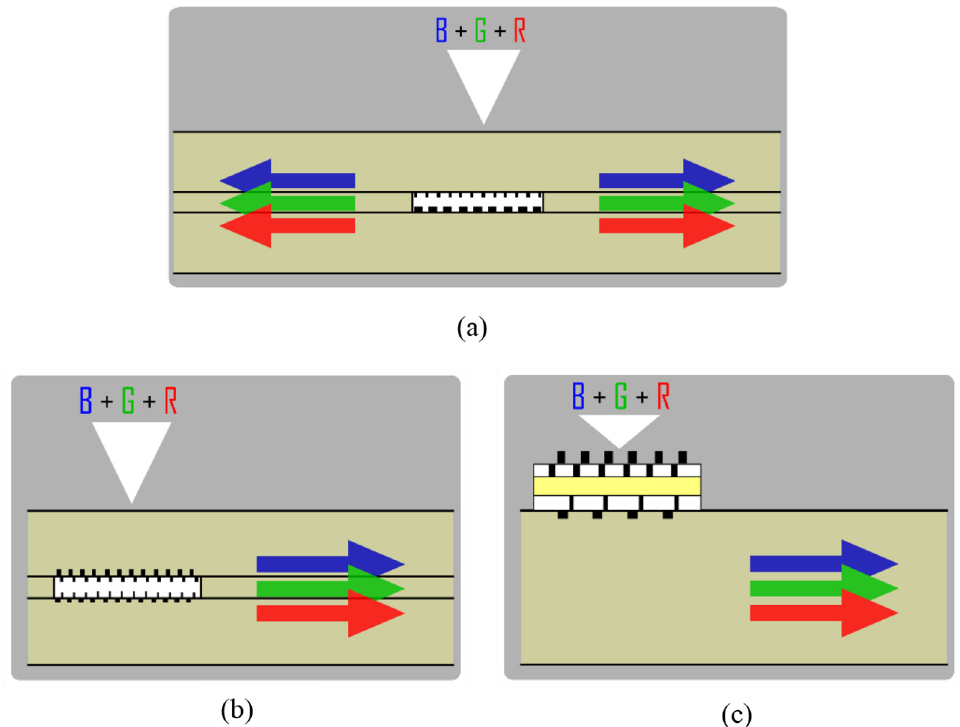
Fig. 2. Schematic side view of the single-waveguide full color system for light in-coupling into the optical device: (a) dual-mode embedded metagrating solution; (b) single-mode embedded metagrating solution; (c) single-mode transmissive